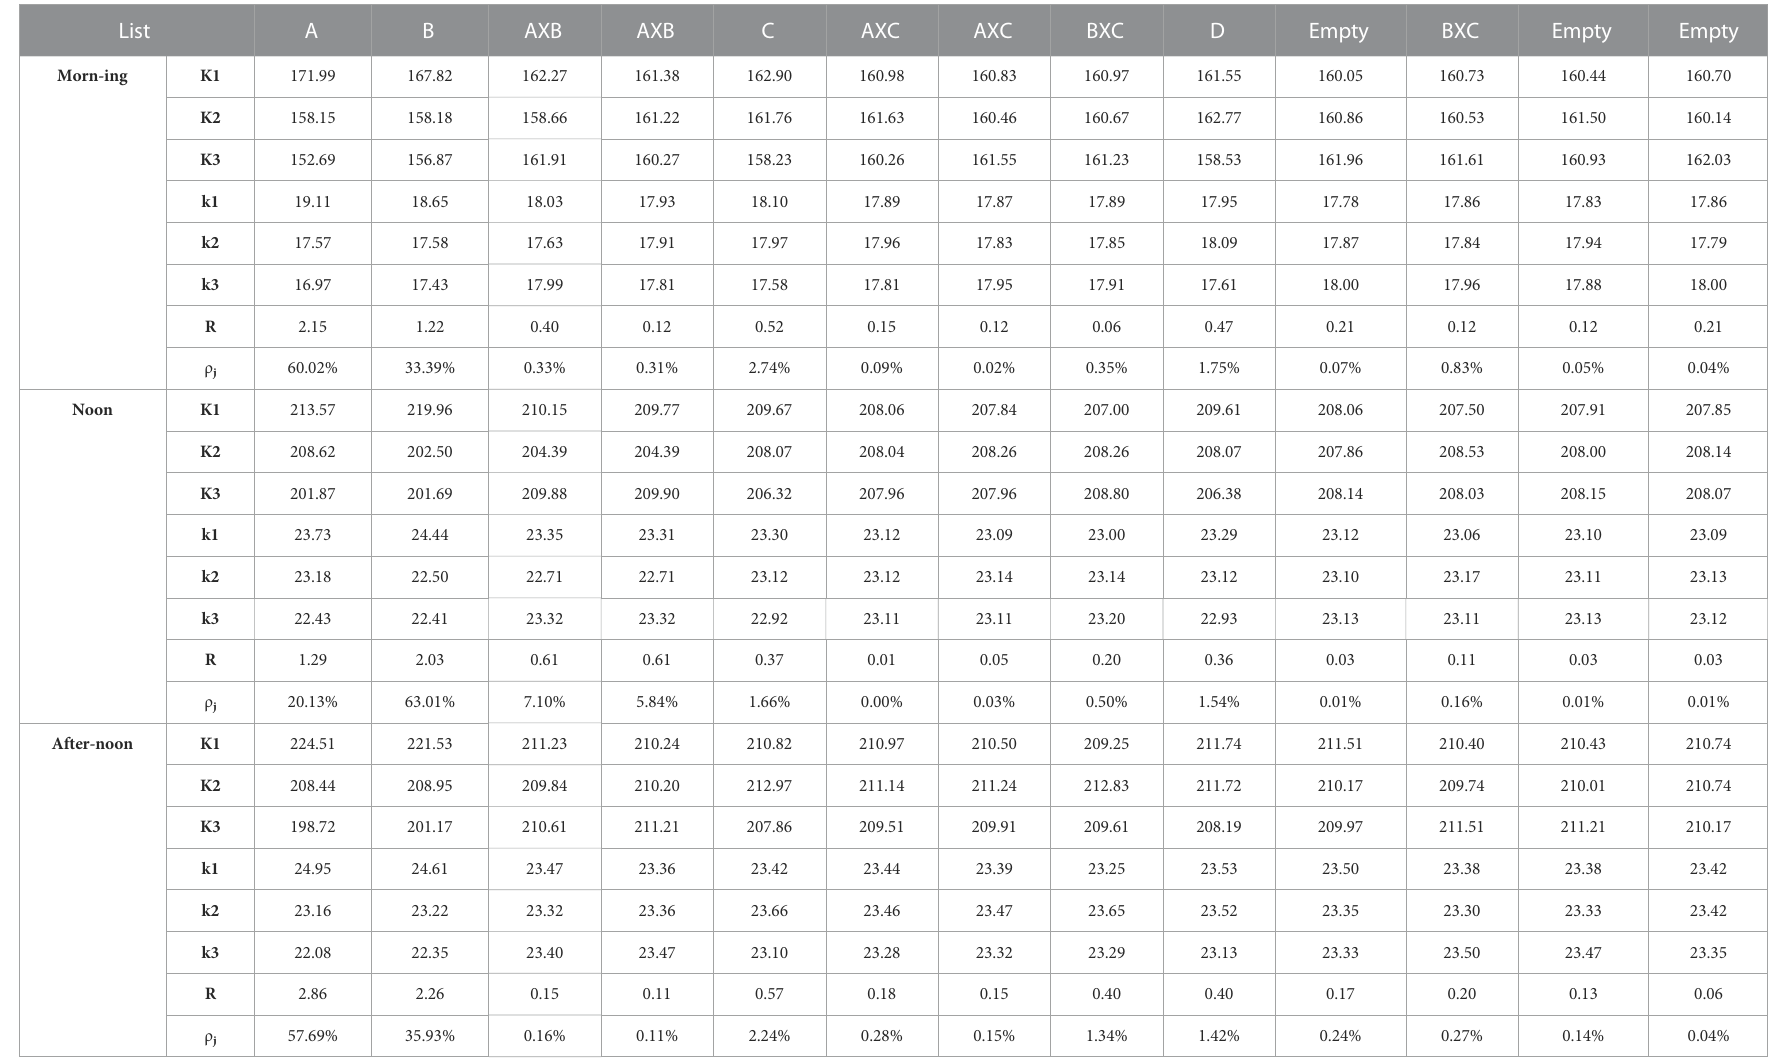
TABLE 9 Results of orthogonal test in summer. List A B AXB AXB Empty BXC Empty Empty Morn-ing